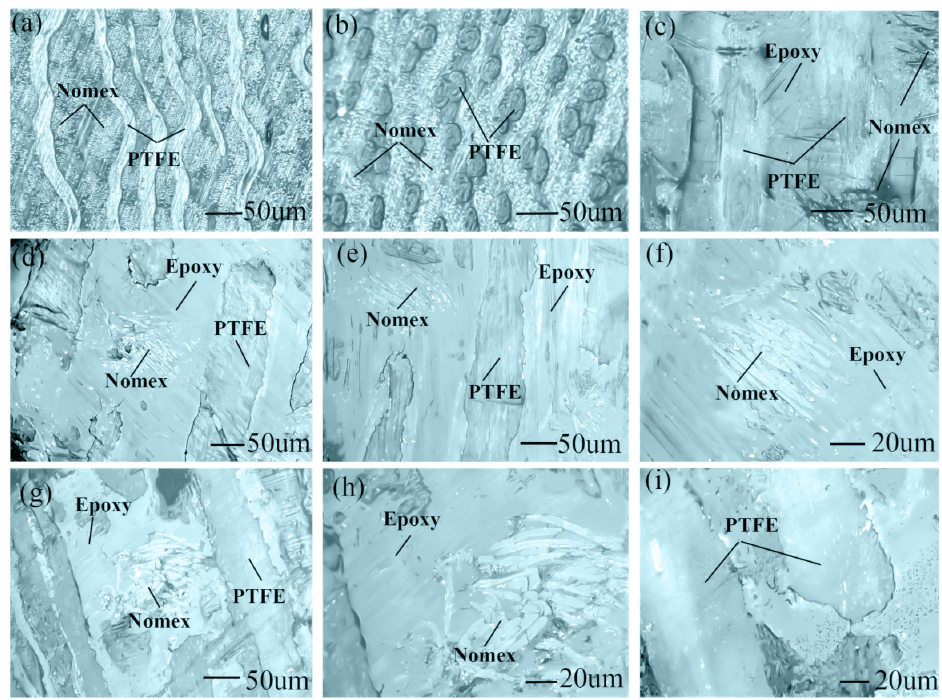
Figure 5. Microscope images of fabric laminate sample, ( a ) vertical cross-section, ( b ) horizontal cross- section, ( c ) working surface. ( d , e ) dry friction worn surface and ( f ) Nomex fibers after dry friction wear. ( g ) Water-lubricated wear surface, ( h ) Nomex fibers and ( i ) PTFE fibers after water-lubricated wear.